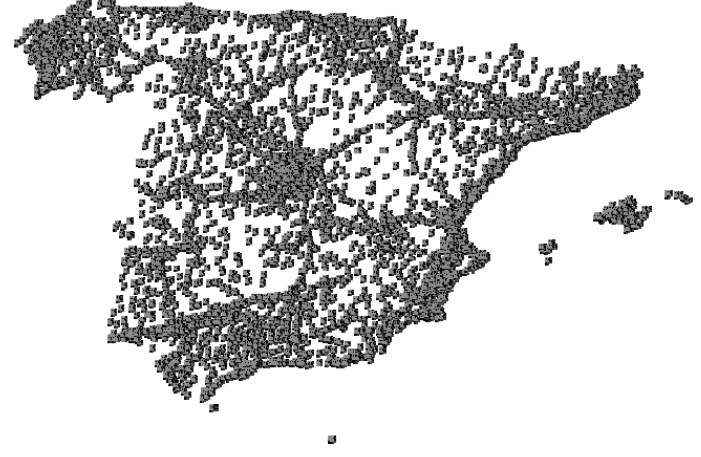
Figure 7. Map of gas stations density in Spain [40]. Reprinted/Reproduced with permission from [40]. Copyright 2013 Ministry of Industry, Commerce and Tourism of